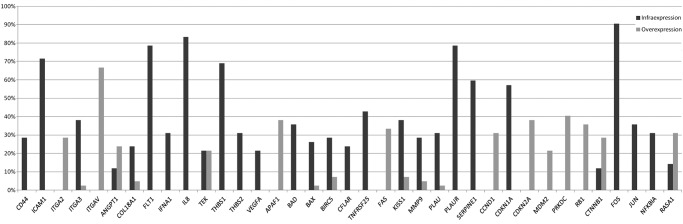
Data obtained from meningiomas with at least 20% deregulation. Genes are named using the official symbols.